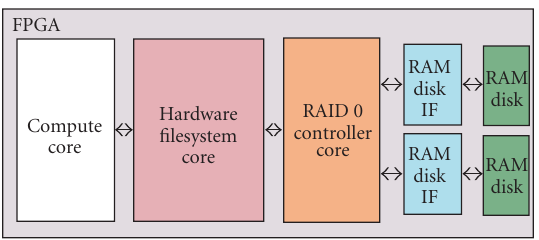
Figure 10: Hardware system level interface between the SATA core and hardware filesystem.